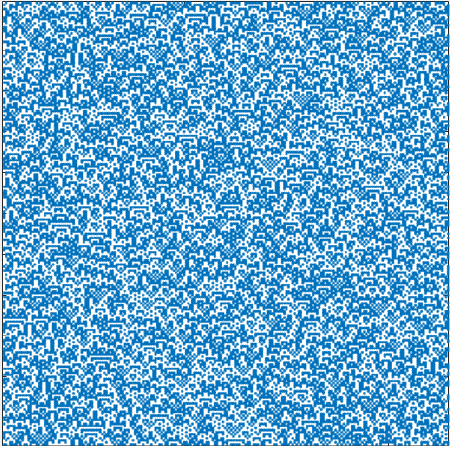
Figure 1. Pseudo chaotic spatiotemporal map of ECA (No.